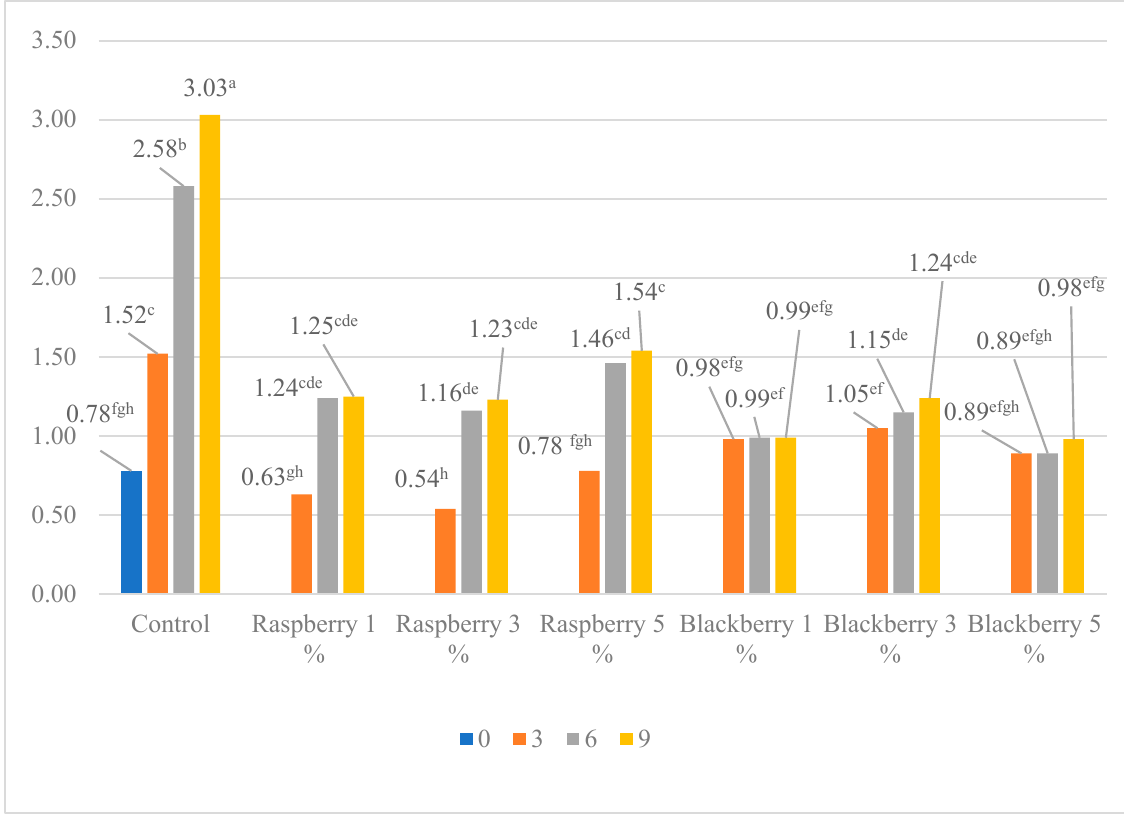
Figure 2. TBARS levels in beef patties stored for nine days, malondialdehyde (MDA) (mg) present in 1 kg of meat. a, b, c, e, f, g, h Values in a columns with different superscripts differ significantly at p ≤ 0.05.